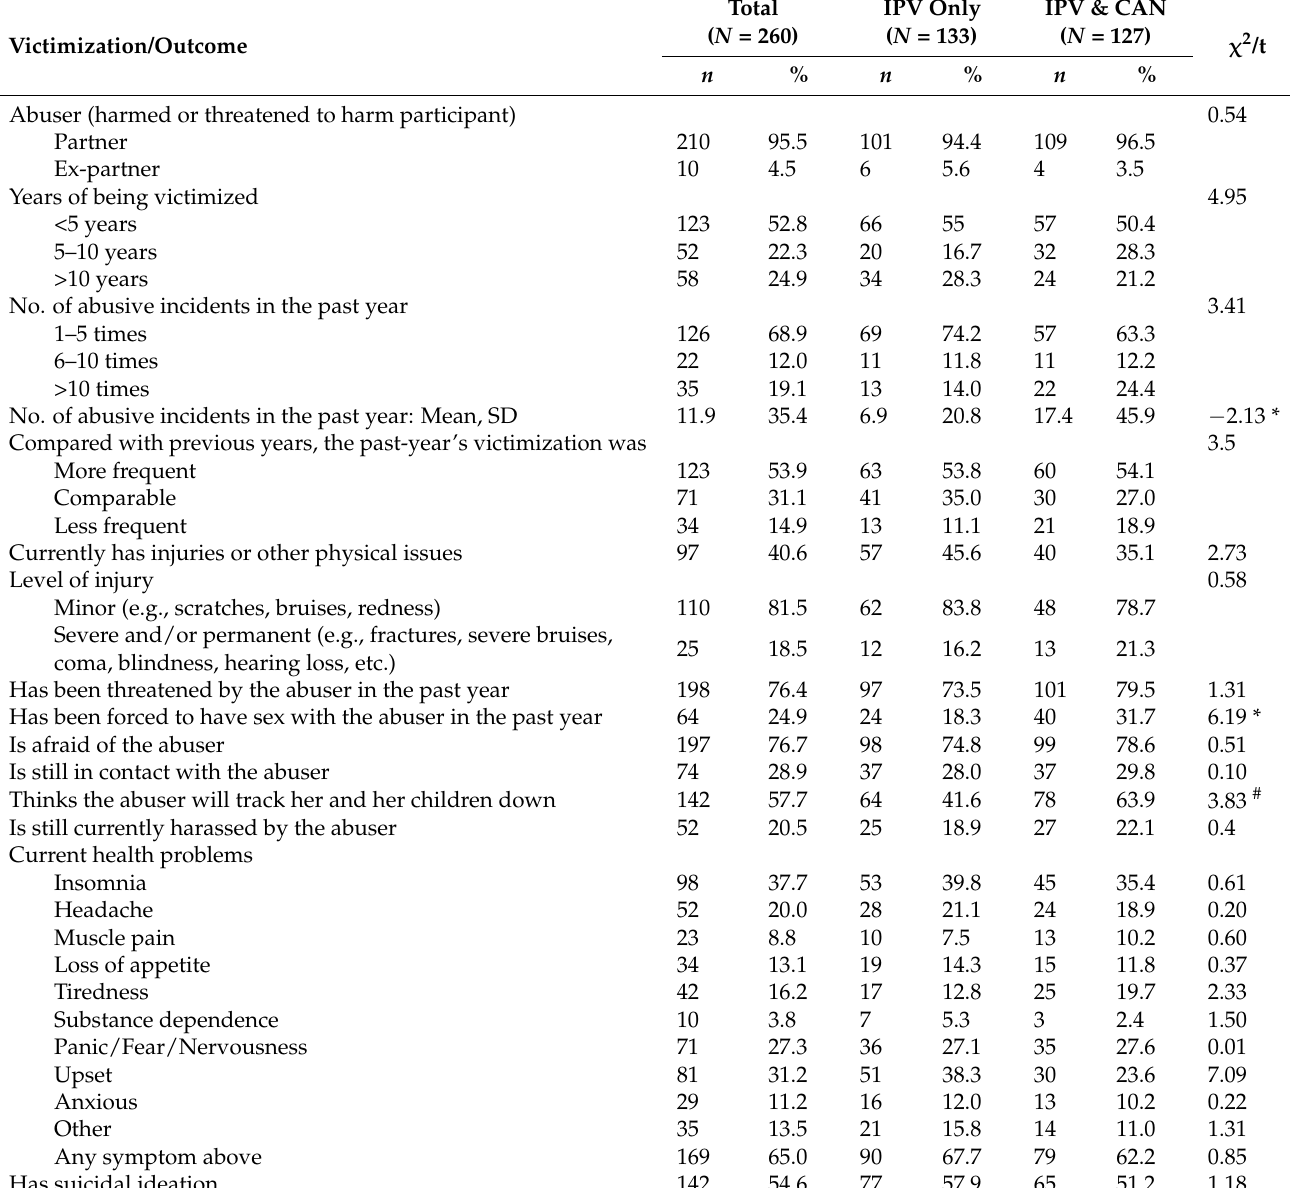
Table 3. IPV Victimization and Health Outcomes of Women